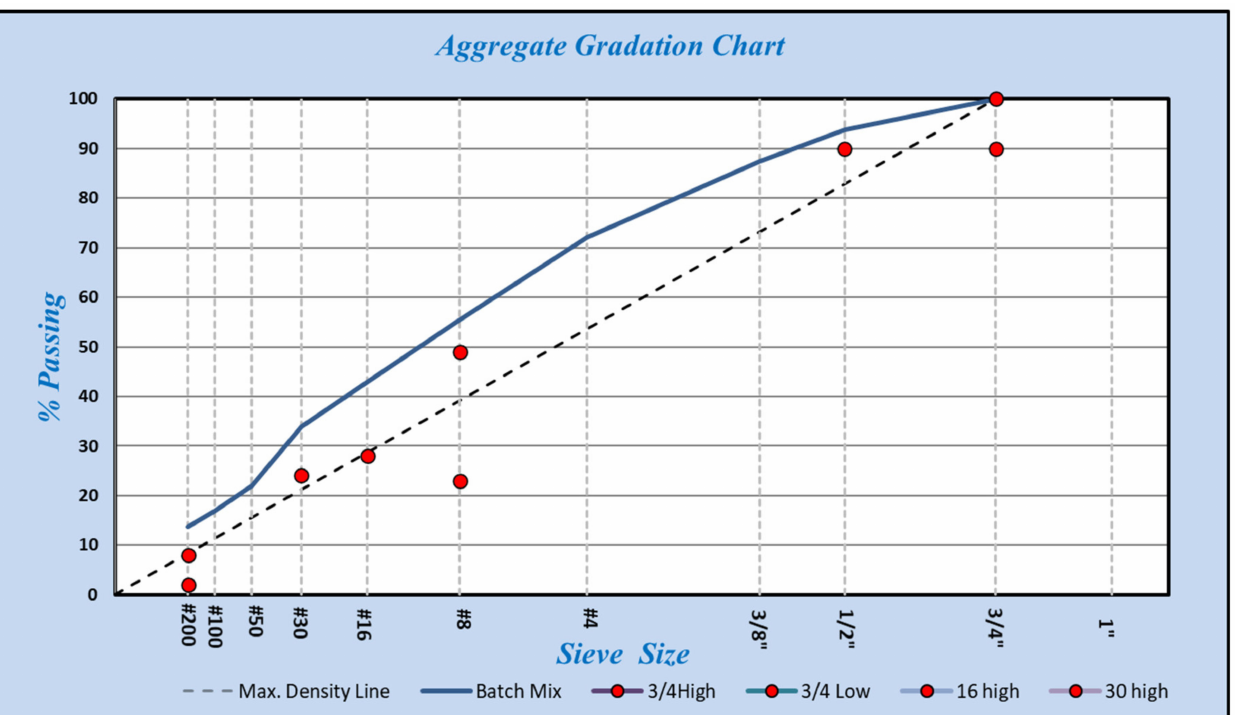
Figure 6. Gradation of extracted aggregates from the RAP